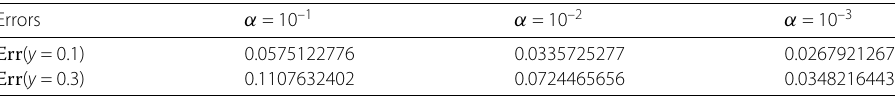
Table 1 The errors between the exact solution and the regularized solution at y = 0.1 and y = 0.3 for α ∈ { 0.1;0.01;0.001 } Errors α = 10 –1 α = 10 –2 α = 10 –3 Err ( y = 0.1) 0.0267921267 Err ( y =